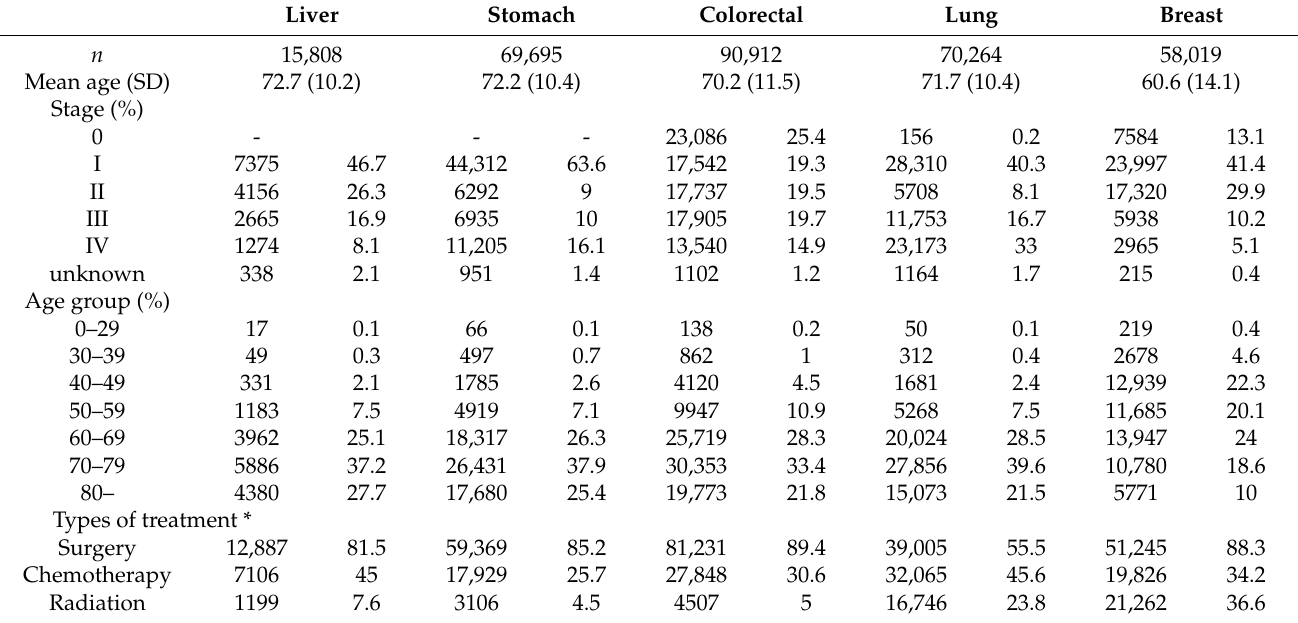
Table 1. Patient demographics